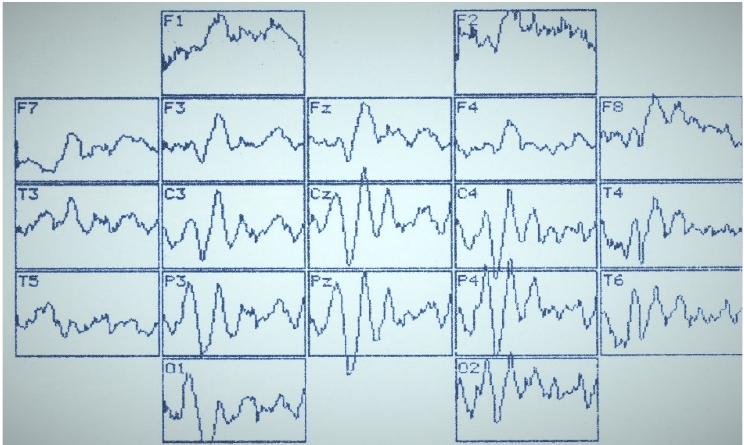
Figure 4. VEP distribution by the 10/20 system with unrecognition of images-illusions. Analysis epoch: 1000 ms.